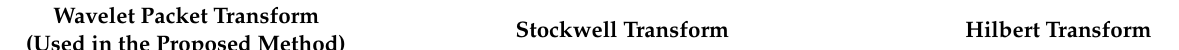
Table 1. Comparative analysis between Stockwell, Hilbert, and wavelet packet